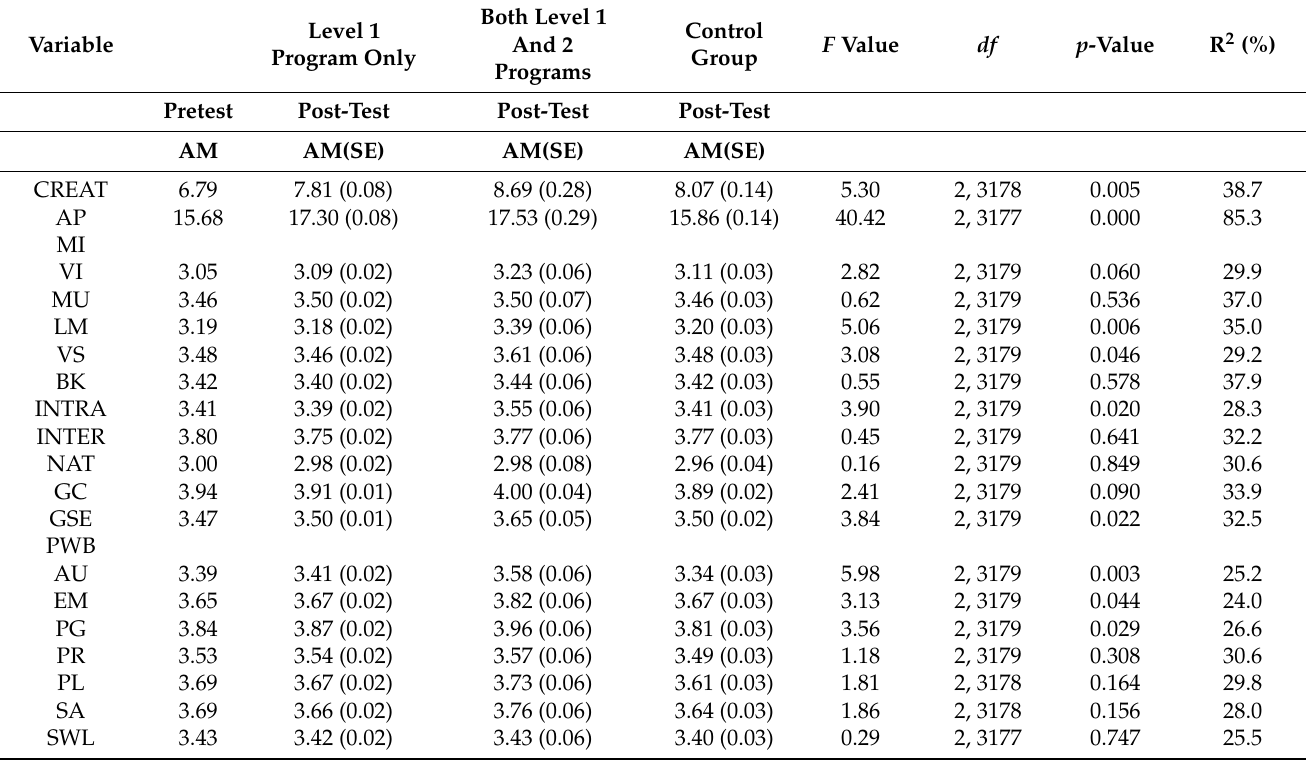
Table 3. Results of one-way ANCOVA on all outcome variables of students in Level 1 program only, both Level 1 and 2 programs, and